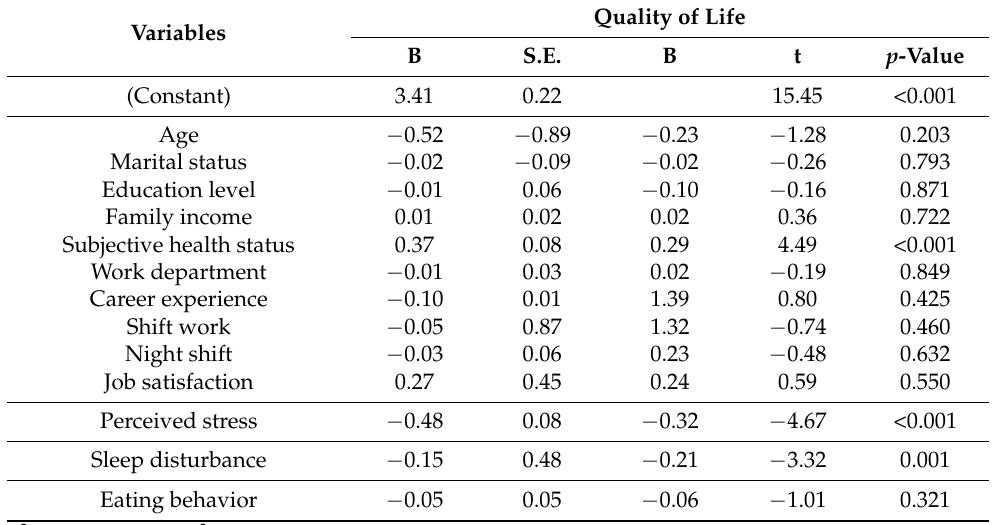
Table 4. Factors influencing quality of